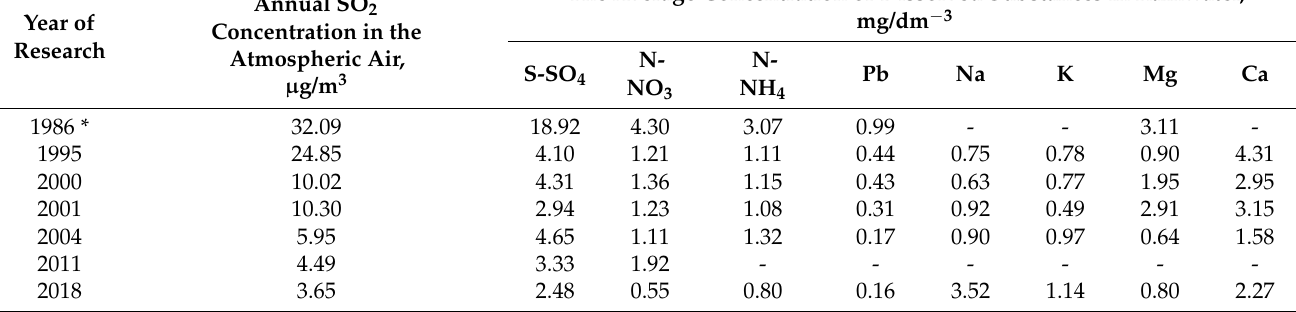
(Table 4) [29,30]. Since the 1990s, there has been a clear downward trend in the deposition amount of not only sulfate ions but also nitrate and calcium. Table 4. Atmospheric air conditions in the years of research based on Kostrzewski, Majewski, 2018,